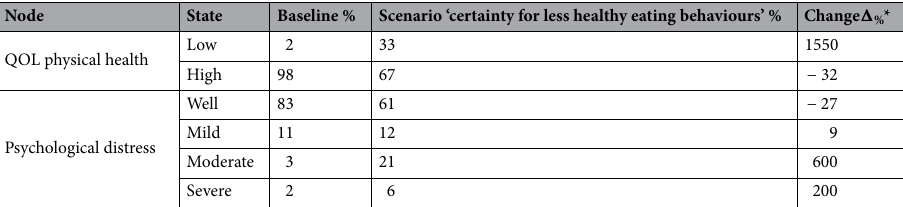
Table 5. Changes from baseline in affected nodes with Scenario 3 ‘certainty for less healthy eating behaviours’. P evidence − P baseline 100%. * (cid:31) % = P baseline ×